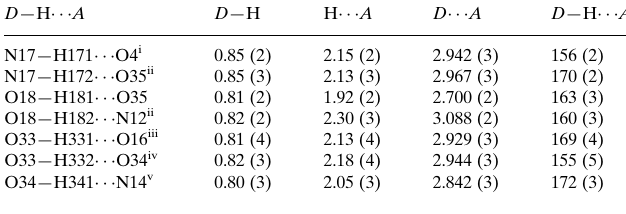
Hydrogen-bond geometry (A˚ , (cid:3)